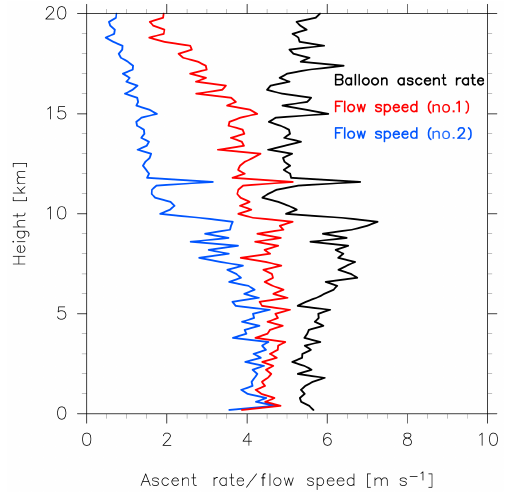
Figure B1. Vertical profiles of balloon ascent rate (black) and the flow speed within a duct (with a similar inner cross section to that of the CPS’s air inlet) attached to a CPS measured with two hot-wire anemometers, one placed ∼ 4cm below the detection area (no. 1, red) and the other ∼ 10cm below the detection area (no. 2, blue). Taken at Moriya, Japan, launched at 17:11:47LT on 23 November 2012. For all three profiles, 0.2km averages were taken.